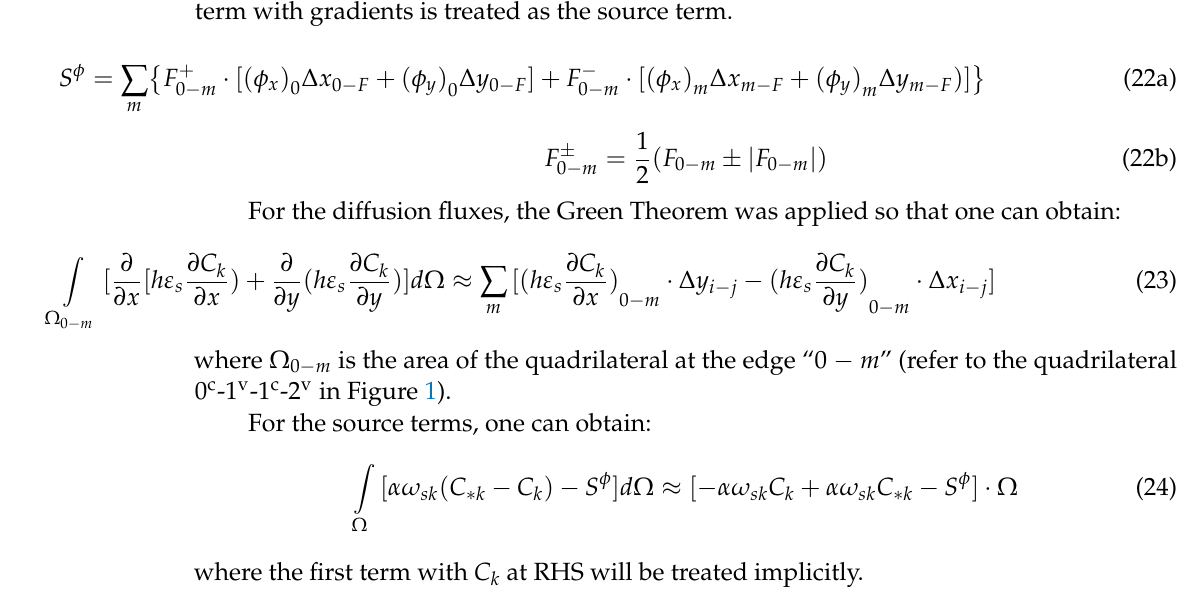
The second-order upwind scheme was used for the edge center “0 − m” , In Equation (21), the first term on the RHS will be treated implicitly, while the second